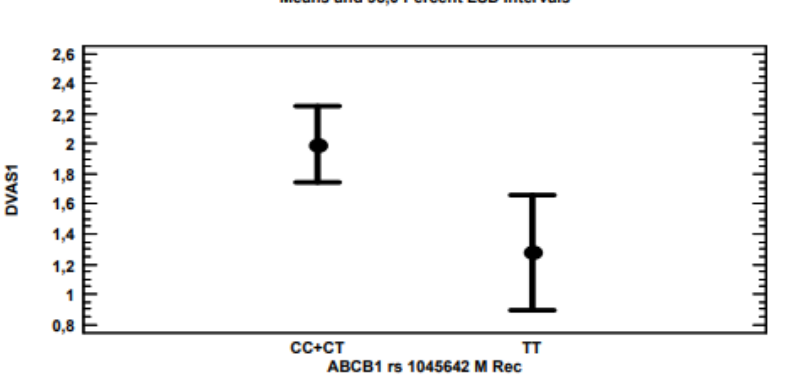
Figure 2. ABCB1 The analysis showed that CC homozygous patients and CT heterozygotes for the ABCB1 gene were associated with an average pain reduction of approximately 2 VAS points, compared to the 1.3 VAS points of TT homozygotes.